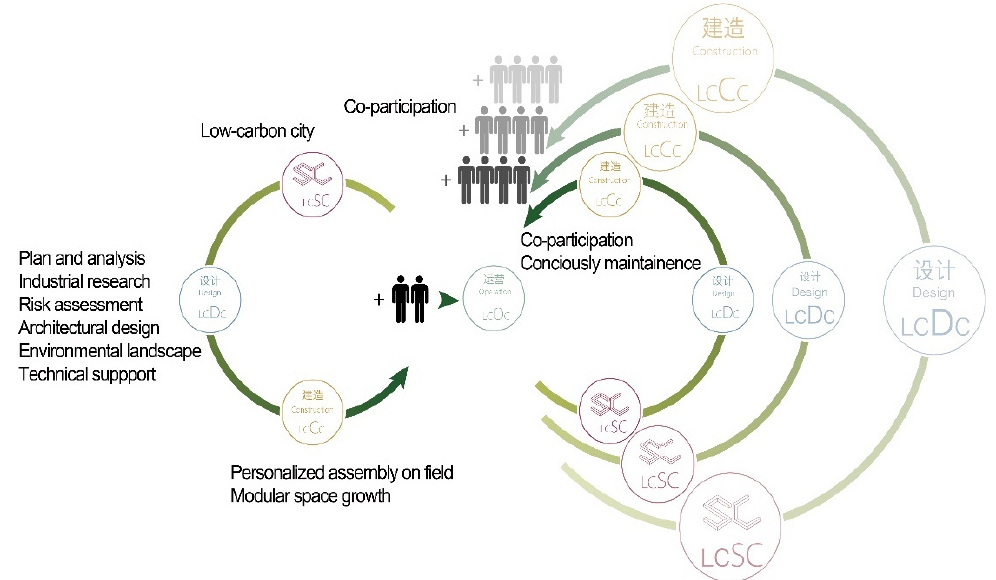
Figure 9. Schematic diagram for the building development strategy: circular relationship among users’ involvement, design, construction, and neighborhood operations (Source: author).